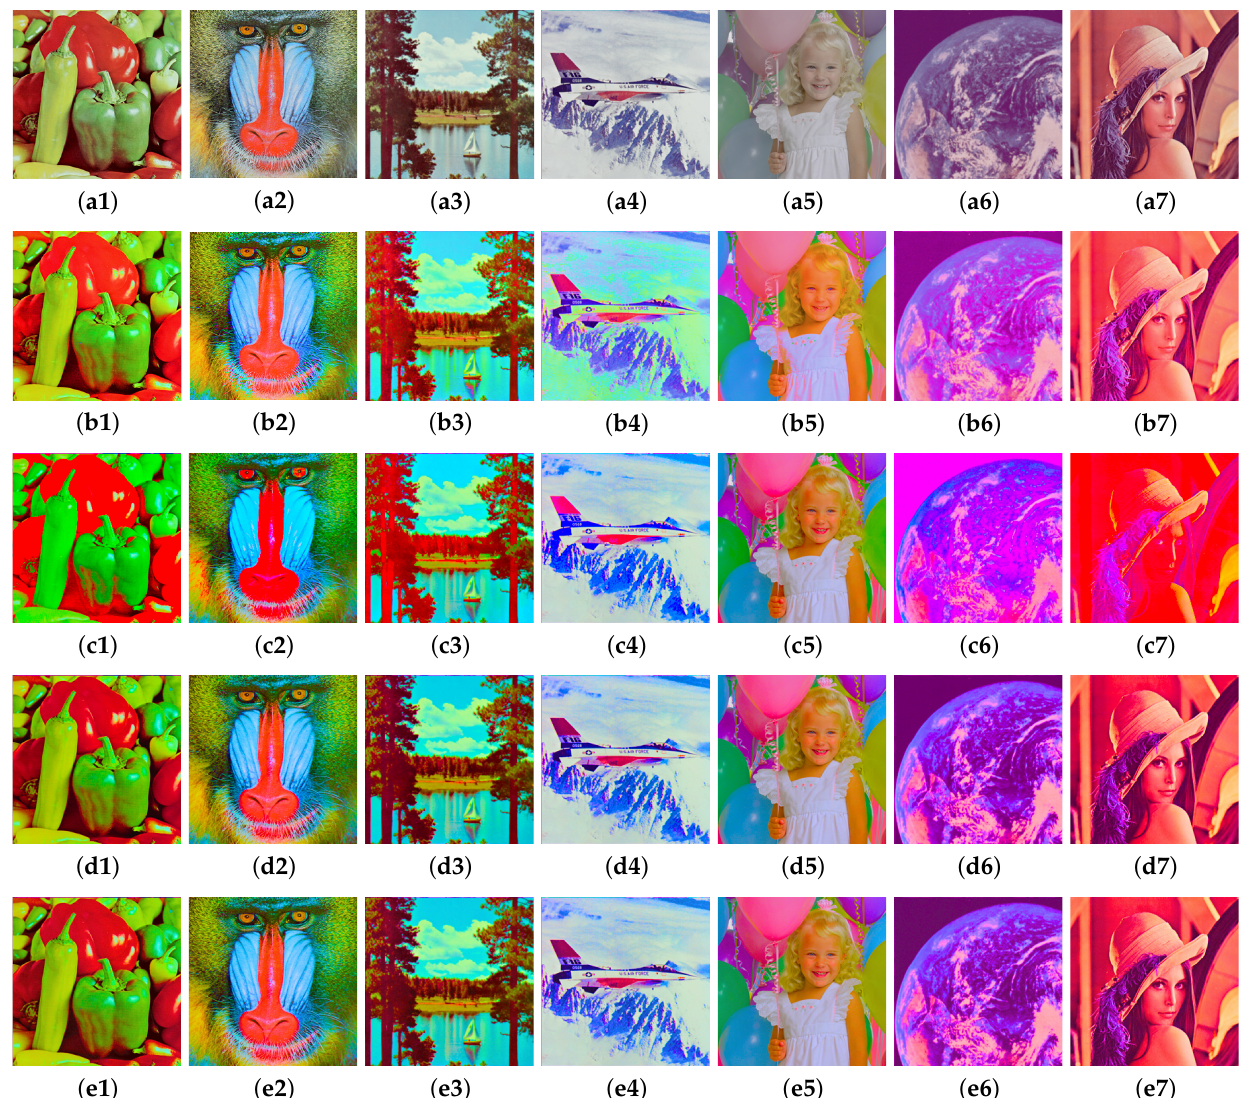
Figure A1. Experimental results: ( 1 ) Pepper, ( 2 ) Mandrill, ( 3 ) Sailboat, ( 4 ) Airplane, ( 5 ) Balloon, ( 6 ) Earth, and ( 7 ) Lenna. ( a1 – a7 ) Original images. Output images by ( b1 – b7 ) chroma enhancement (RGB, γ = 10), ( c1 – c7 ) chroma enhancement (CIELAB, k = 5), ( d1 – d7 ) chroma enhancement (CIELAB, k = 5) and color gamut adjustment by our previous method, and ( e1 – e7 ) chroma enhancement (CIELAB, k = 5) and color gamut adjustment by the lookup